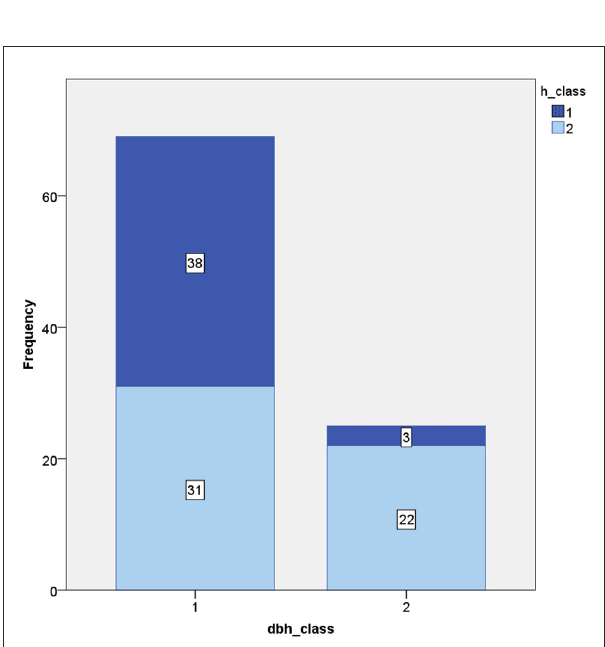
FIGURE5 Natural regeneration tree classification (NRTC) results are organized by h class according to dbh class results.